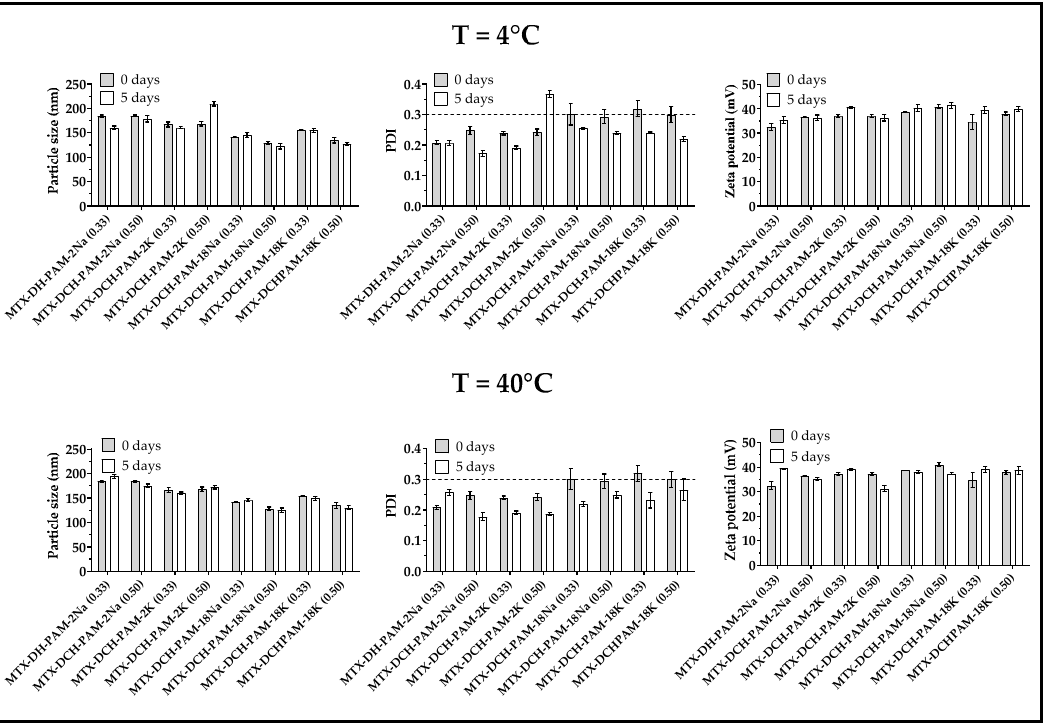
◦ C and 40 ◦ C for MTX-loaded nanoparticulate Figure 4. Stress studies conducted at 4 °C and 40 °C for MTX-loaded nanoparticulate systems. Figure 4. Stress studies conducted at 4